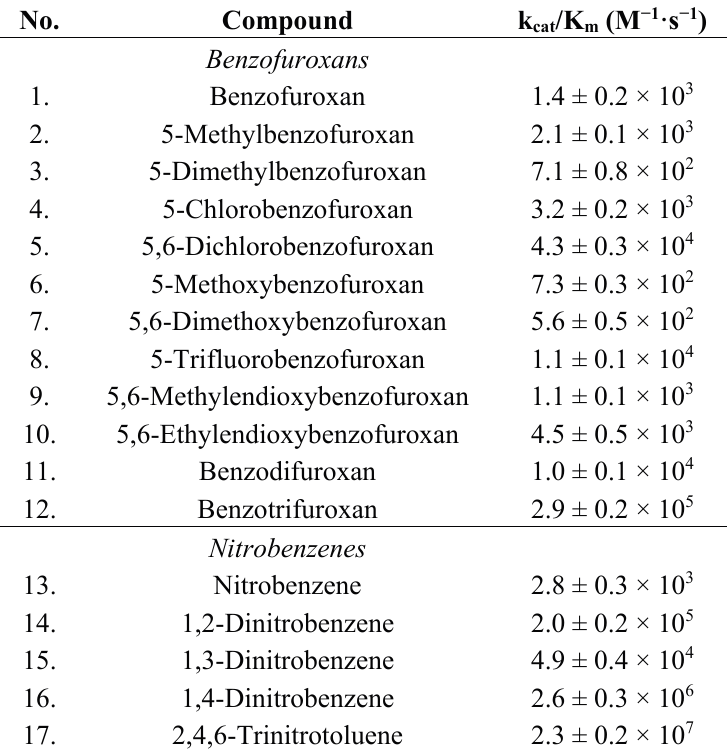
Table 2. The apparent second-order rate (k cat /K m ) constants of reduction of BFXs and NACs by NADPH:cytochrome P-450 reductase (P-450R), pH 7.0, 25° C. All kinetic measurements were performed at fixed concentration of NADPH (150